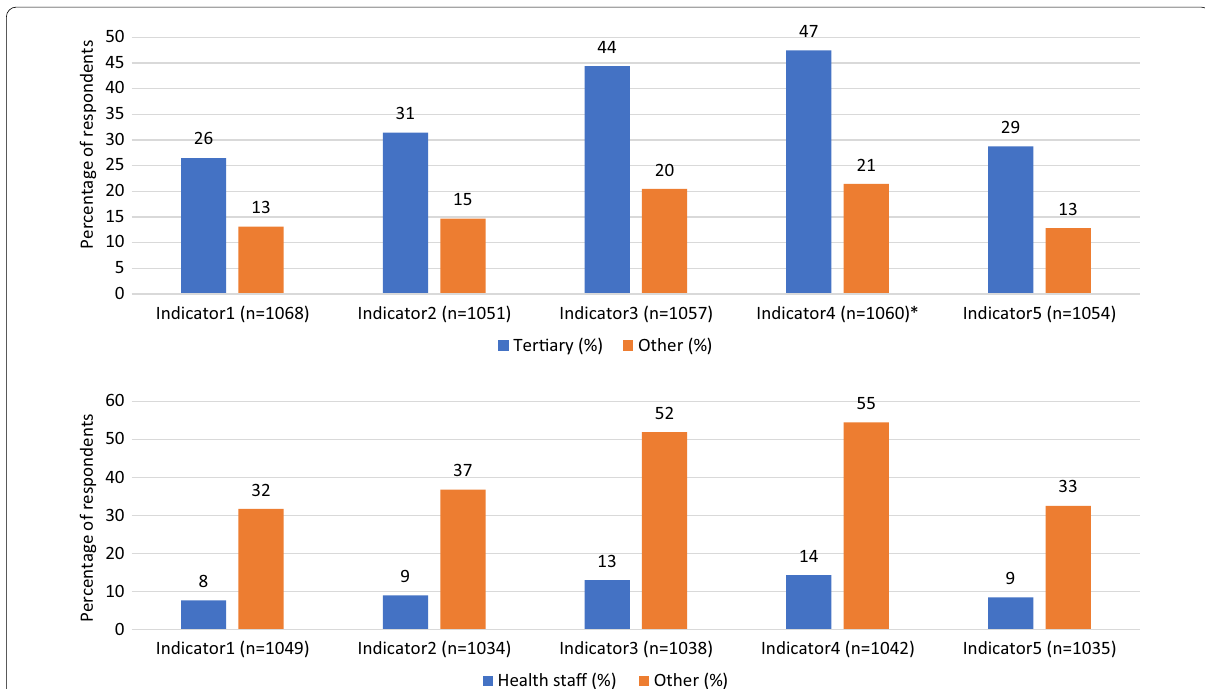
Fig. 3 Perceptions on COVID‑19 vaccination: disaggregated by education and occupation. Source: Field Data (2020); Legend: Indicator1 (Participate in COVID‑19 vaccine trial); Indicator2 (Advise someone to participate in COVID‑19 vaccine trial); Indicator3 (Accept/take vaccination for COVID‑19); Indicator4 (Advise someone to accept/take COVID‑19 vaccination); Indicator5 (Willingness to pay for COVID‑19 vaccination); *Chi‑square test statistically significant at 95% confidence